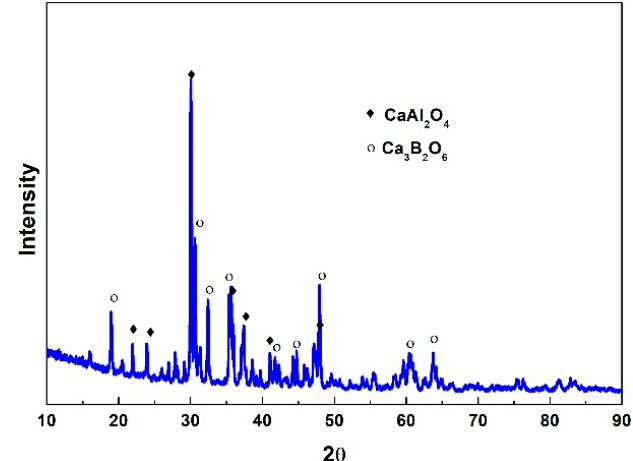
Figure 11. XRD patterns of the CaO–Al 2 O 3 -based mold flux at the cooling rate of 5 °C·min − 1 .